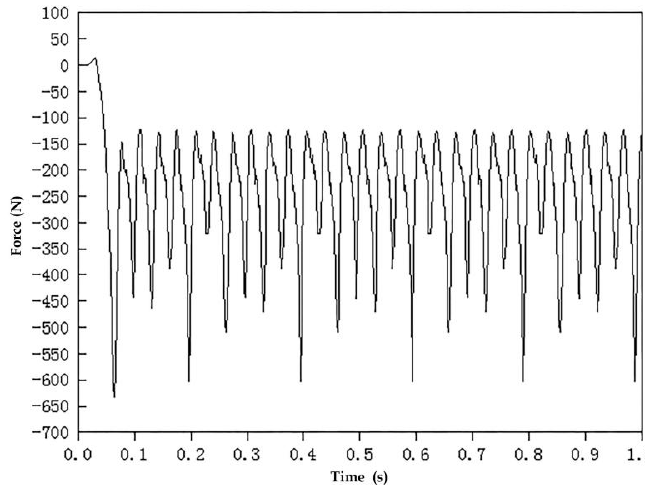
Figure 18. The force waveform of the rotor in power generation stage.